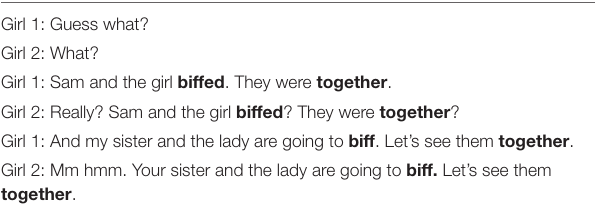
TABLE 5 | Dialogue presented to English participants during the Familiarization Phase of Experiment 1b (“Predicative” condition). Girl 1: Guess what? Girl 2: What? Girl 1: Sam and the girl biffed . They were together . Girl 2: Really? Sam and the girl biffed ? They were together